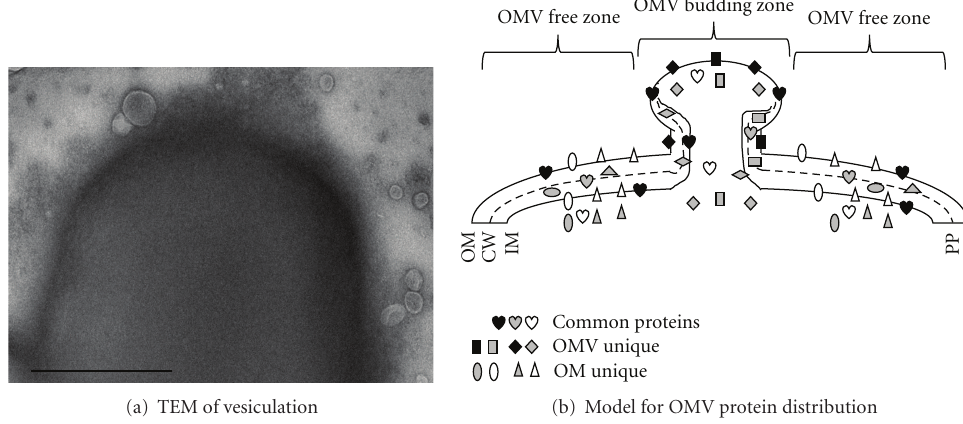
Figure 6: EF-Tu delivery model. (a) A cell with budding and released OMVs revealed by TEM. Bar: 250 nm. (b) A model derived from the OM and the OMV subproteomic data as well as the immune TEM observations, depicting an OMV budding upwards (see Discussion for details). OM: outer membrane; CW: cell wall; IM: inner membrane; PP: periplasm. Proteins in three subproteomes (common, OMV unique and OM unique) are indicated